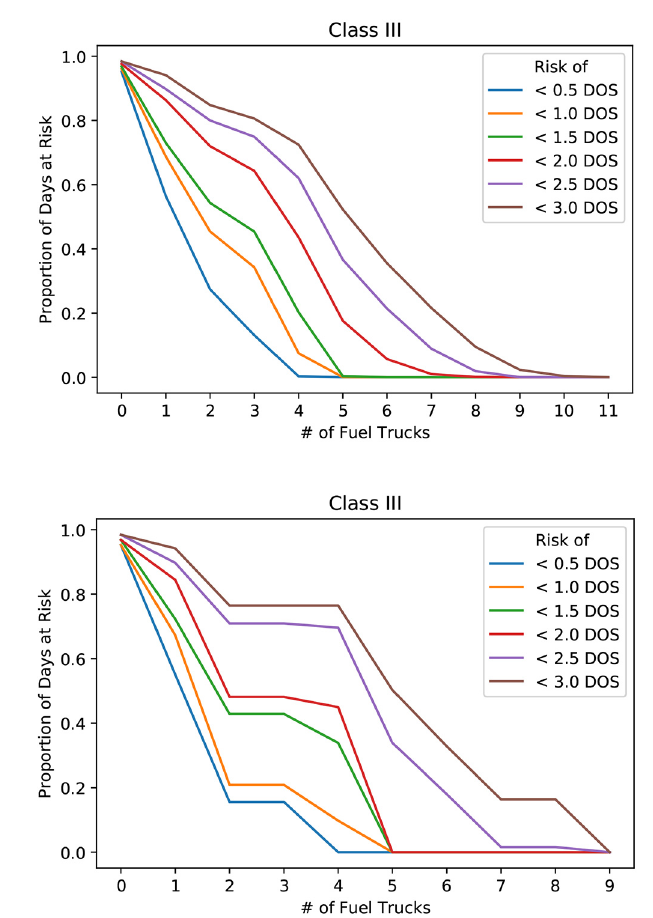
Figure 5. Simulation with